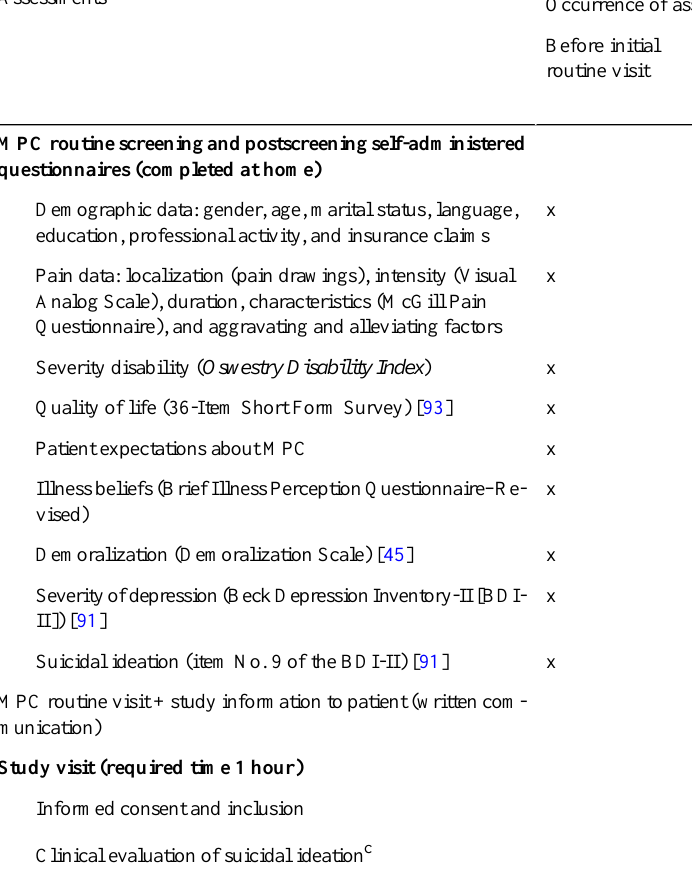
Occurrence of assessment a at each project